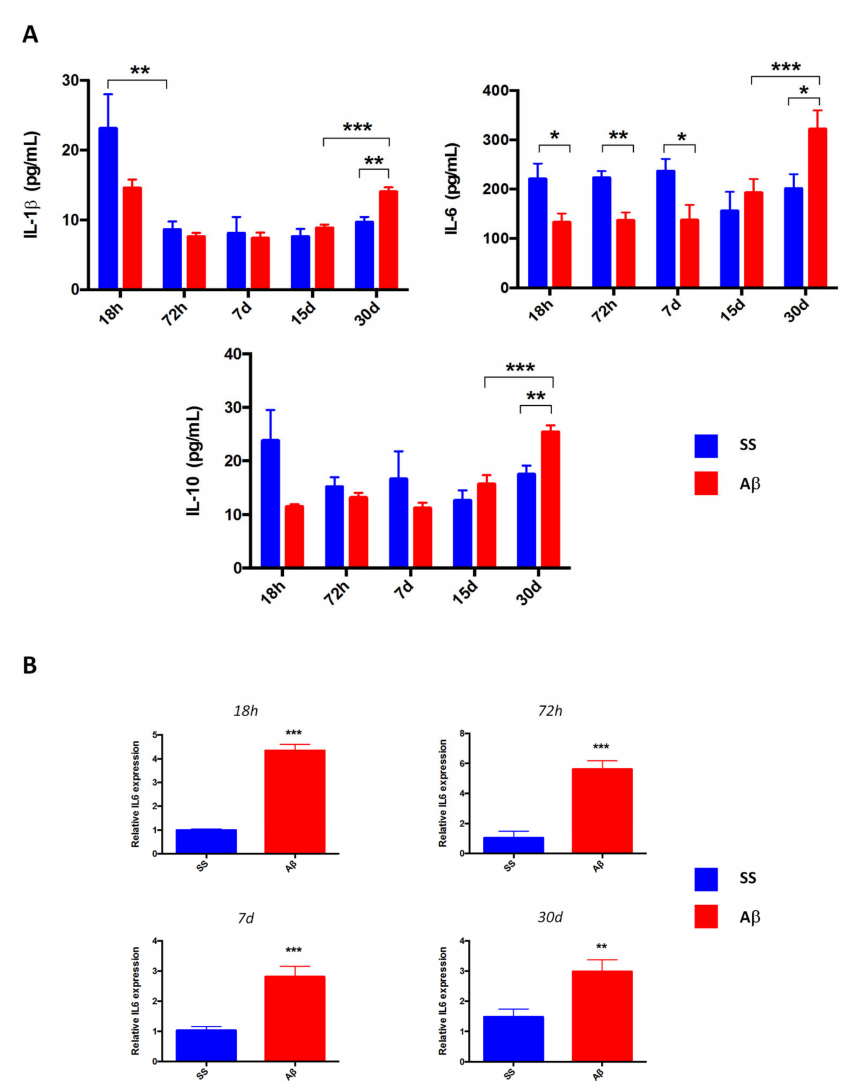
Figure 8. Cytokine quantification and IL-6 expression. ( A ) Quantitative analysis in hippocampus homogenates ( n = 4) reveals an increased release of IL-1 β , IL-6, and IL-10 after 30 days of A β O microinjection. Interestingly, IL-6 decreased in A β groups sacrificed after 18 h, 72 h and 7 days. ( B ) qPCR analysis ( n = 6) shows an increased IL-6 mRNA relative expression in A β rats sacrificed at 18 h, 72 h, 7 days and 30 days. Cytokine levels (pg / mL) are presented as mean with SEM bars. IL-6 mRNA expression was normalized with β -actin. Data are expressed in average fold change with SEM bars. Significance level * p < 0.05, ** p < 0.01, and *** p < 0.001 are